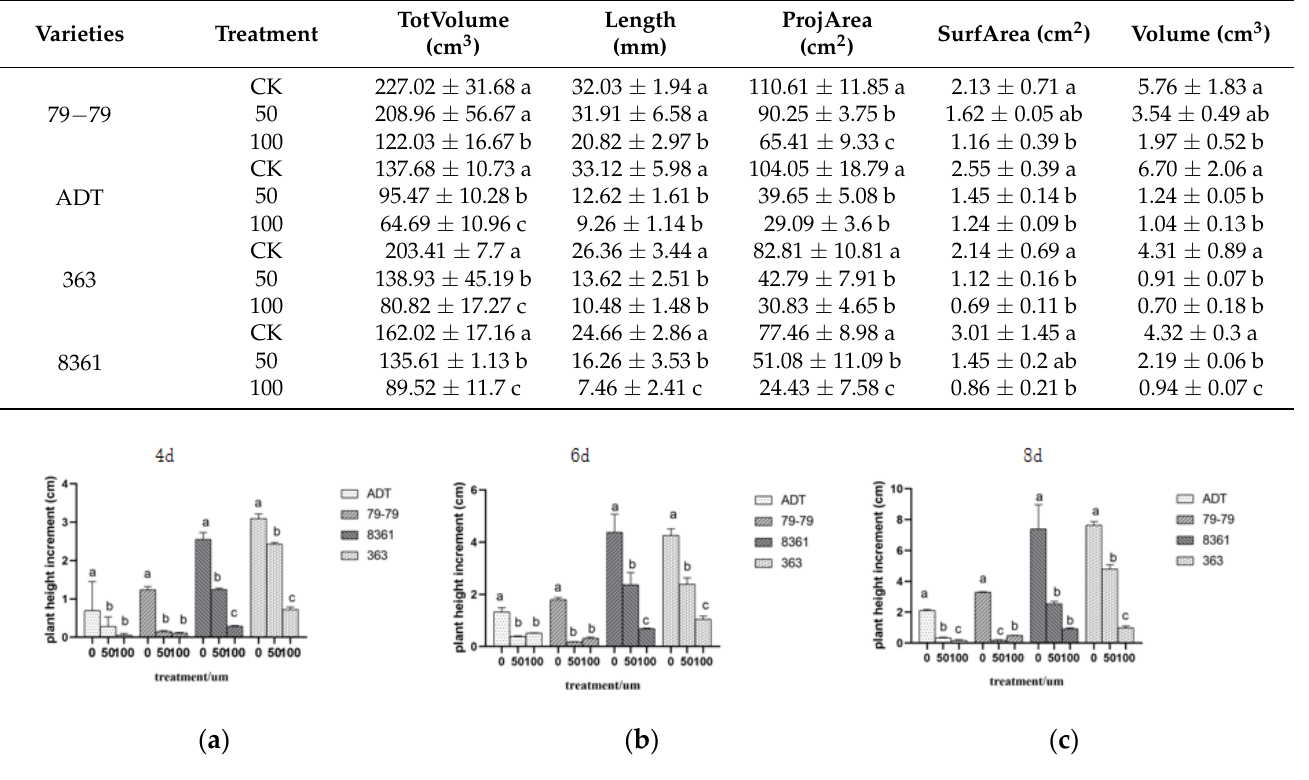
Figure 3. Plant height increments after 4, 6, and 8 days of cadmium treatment. Within each sunflower variety, the different letters indicate a significant difference at the p < 0.05 level, according to Duncan’s multiple range test. ( a ) is 4d of plant height increment, ( b ) is 6d of plant height increment, ( c ) is 8d of plant height increment.